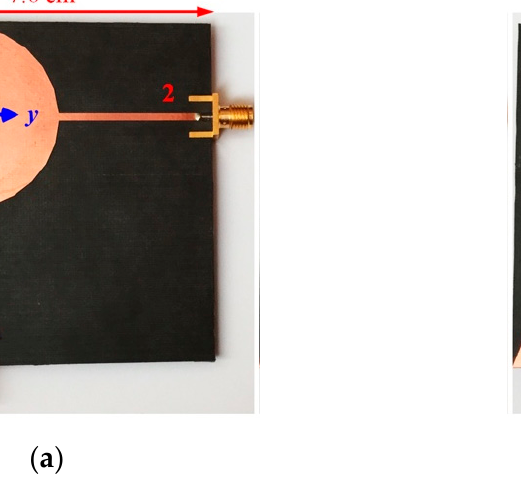
Figure 6. Fabricated two-port antenna: ( a ) top view; and ( b ) bottom view.